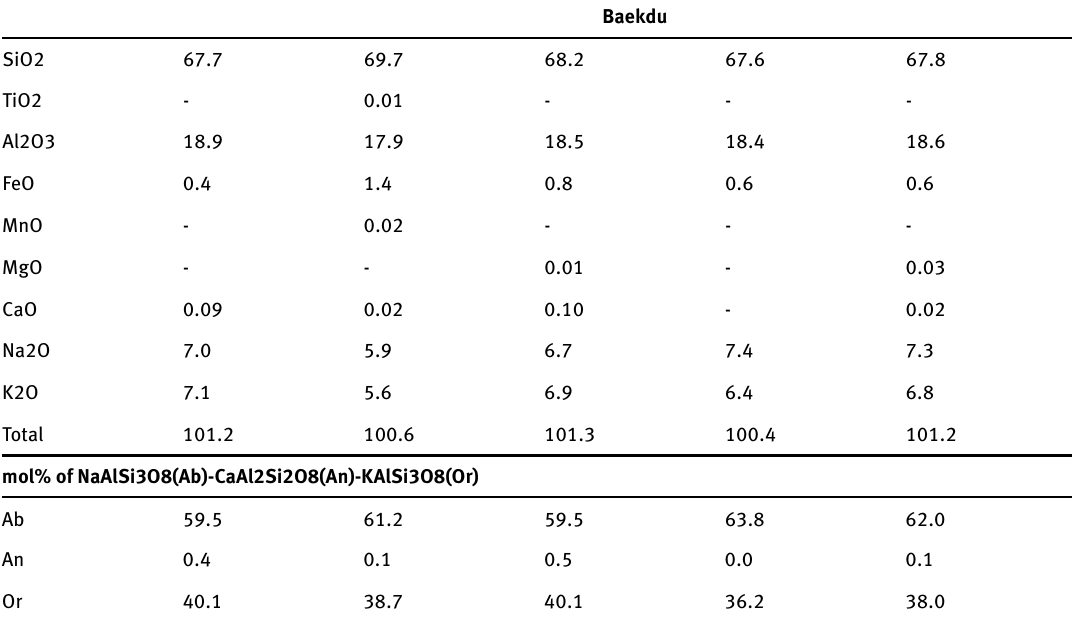
Table 3. Chemical compositions (wt.%) of feldspar microlites in the Baekdusan